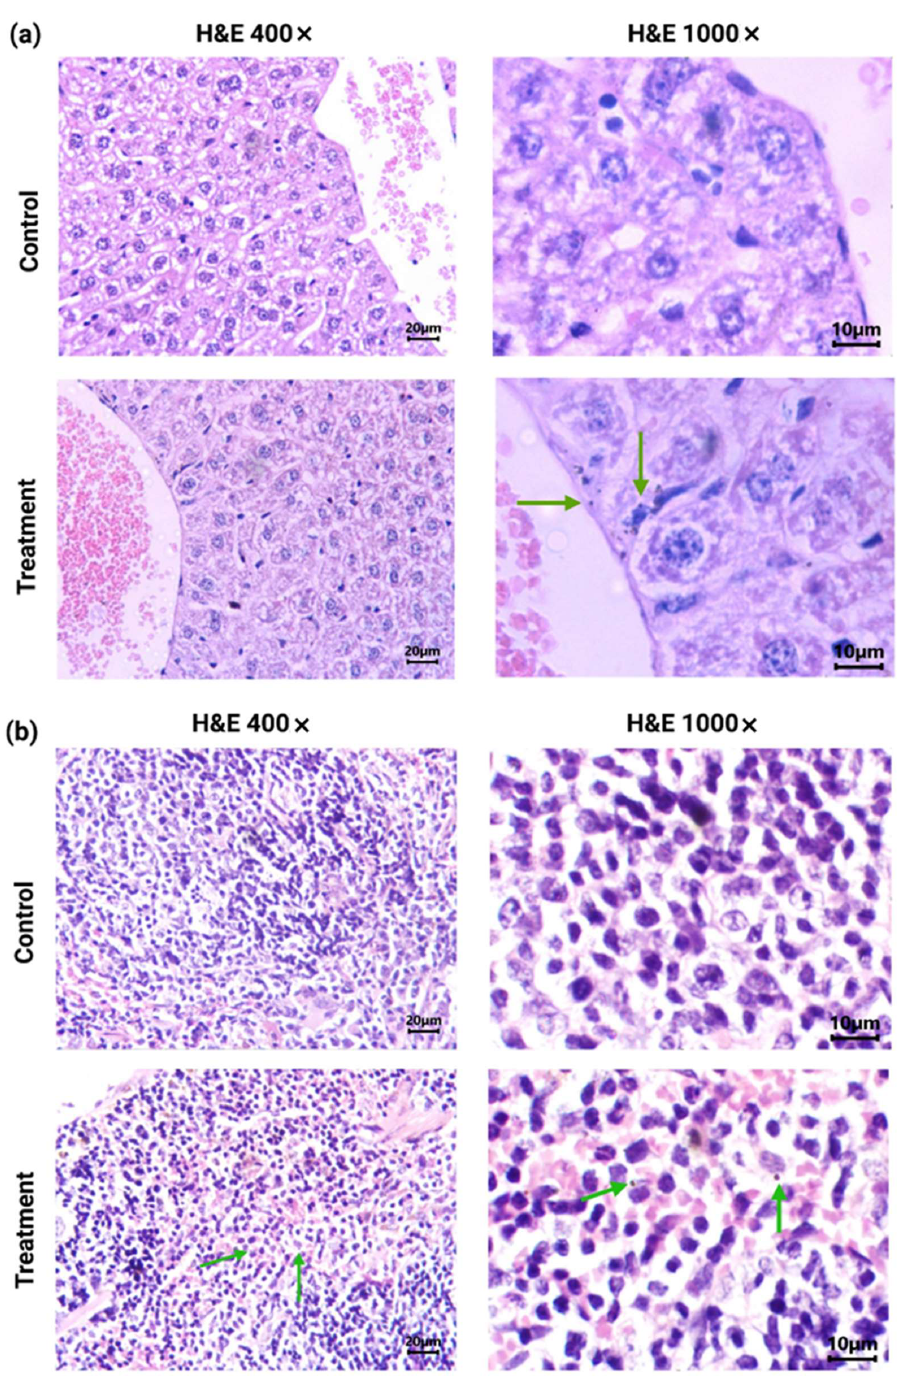
Figure 5. Histological analysis (H&E staining) (light micrographs): ( a ) representative sections at 400× and 1000× magnification of the liver from [ 177 Lu]Lu−iFAP/iPSMA-treated and control mice; ( b ) representative sections at 400× and 1000× magnification of the spleen from [ 177 Lu]Lu−iFAP/iPSMA-treated and control mice. Note the presence of nanoparticle clusters, especially within macrophages (green arrows). The liver of mice treated with [ 177 Lu]Lu−iFAP/iPSMA nanoparticles exhibited no his- topathological abnormalities. No granulomas or hemorrhages were observed. There was